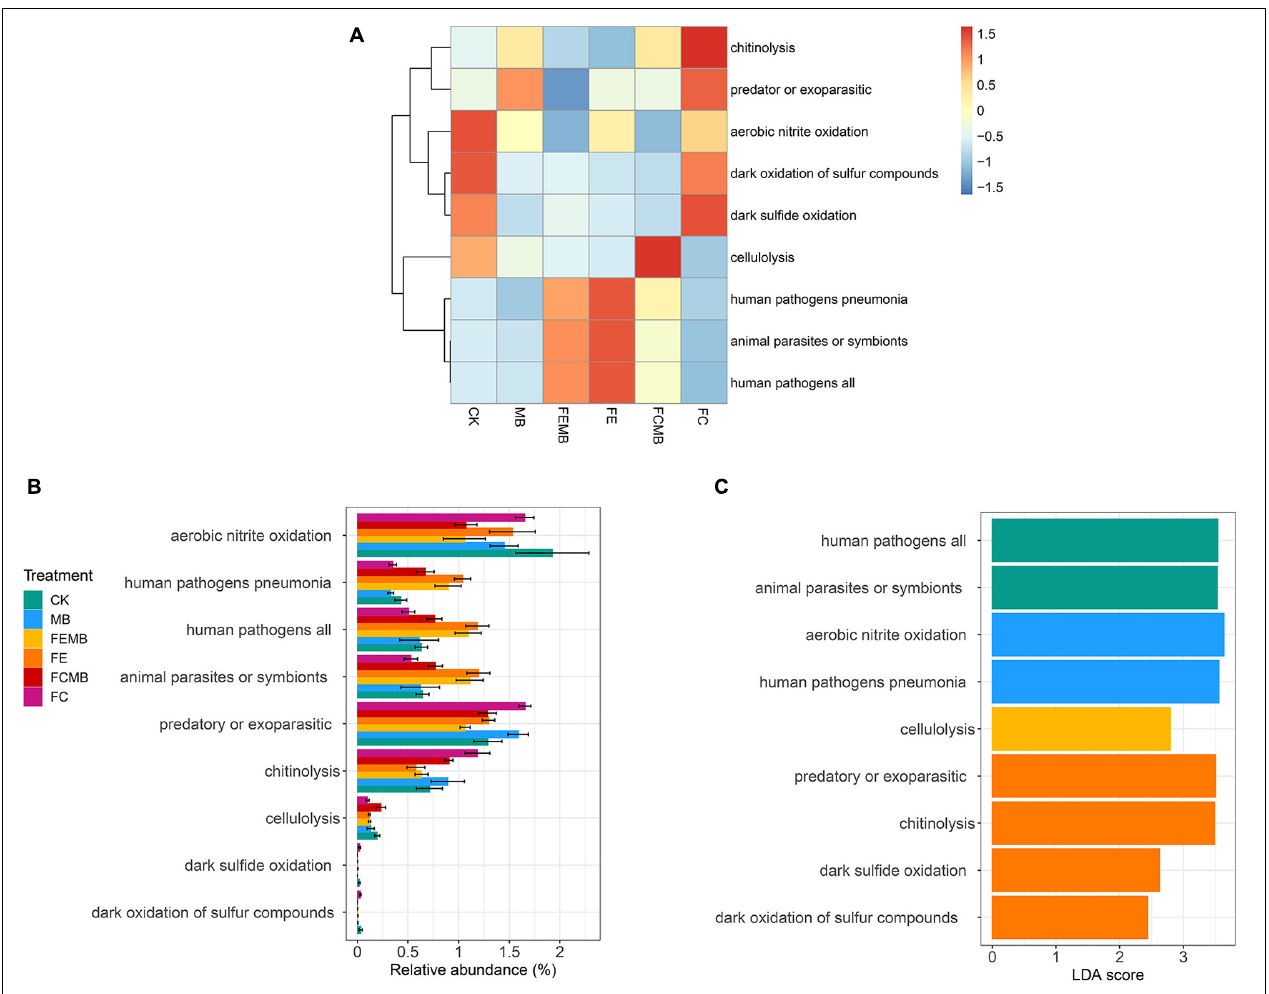
FIGURE 5 | Microbial functional diversity (FAPROTAX) in the field grown with H. cordata under different fertilization regimens. (A) Relative abundance heatmap of the functions. (B) Relative abundance barplot of the functions. (C) Linear discriminant analysis (LDA) showing the prominent functions.